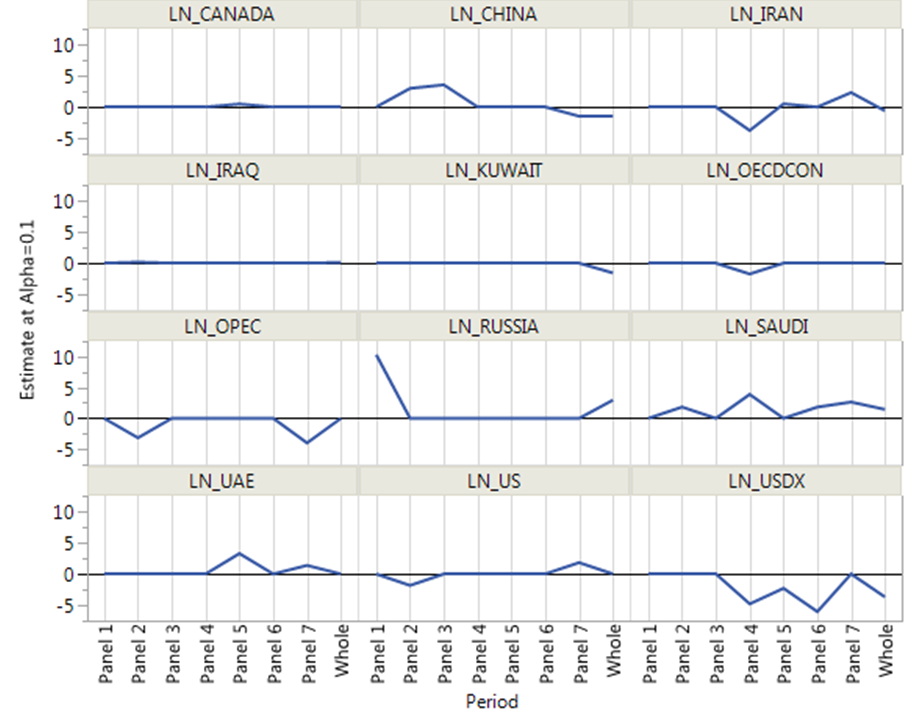
Figure 6. Coefficient estimates of variables by producer and panel at a significance level of 0.1.